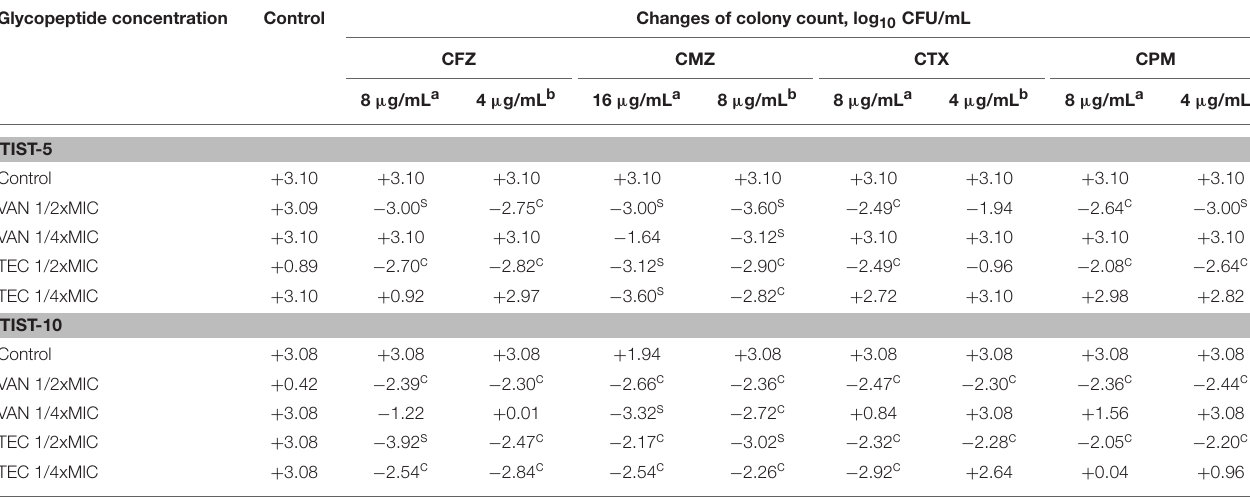
TABLE 4 | Colony count changes at different concentrations of vancomycin or teicoplanin combined with a cephalosporin at the inhibitory or sub-inhibitory concentration. Glycopeptide concentration Control Changes of colony count, log 10 CFU/mL CFZ